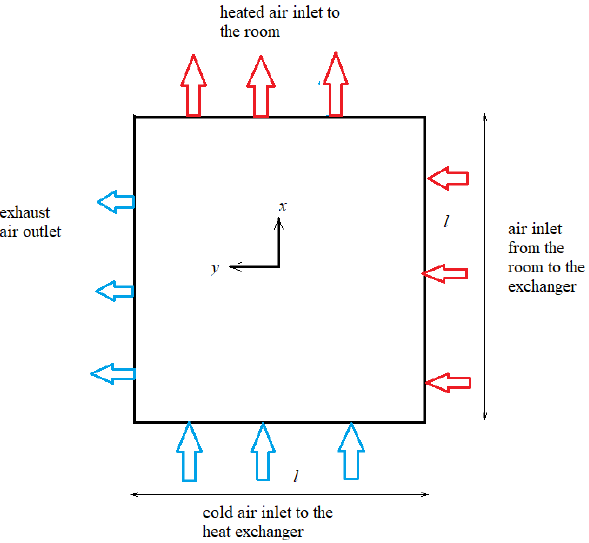
Figure 1. Cross-flow heat exchanger.